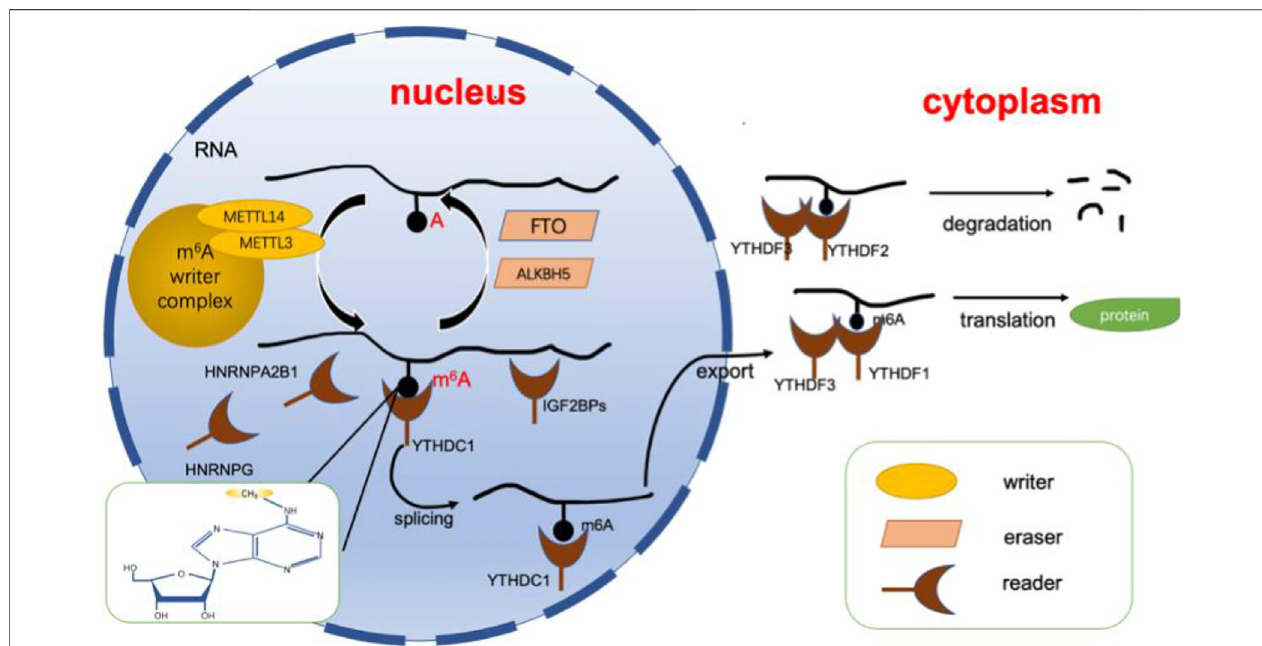
FIGURE 1 | Dynamic regulation of RNA m 6 A modi fi cation. The dynamic regulation of RNA m 6 A modi fi cations relies on writers (including METTL3, METTL14, WTAP, etc.) erasers (including FTO, ALKBH5, etc.), and readers (including YTHDFs, YTHDCs, HNRNPs, etc.). Adenosine located in RNA is recognized by writers for methylation,whileeraserscancatalyzethedemethylationofm 6 A.Finally,themodi fi cationisrecognizedbythereaderprotein,allowingittoperformitsfunction.ALKBH5, alkBhomolog5;FTO,fatmassandobesity-associatedprotein.m 6 A,N6-methyladenosine;YTHDF,YTHN6-methyladenosine,RNAbindingprotein,YTHDC,YTH domain containing protein, HNRNP, heterogenous nuclear